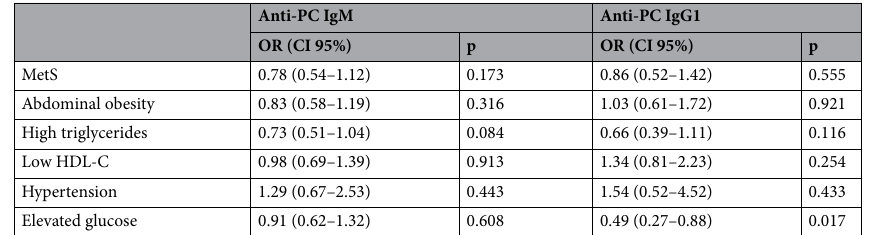
Table 4. Associations between anti-PC and MetS, including each component of MetS. Values are odds ratios (OR) with 95% confidence intervals (CI95%). MetS – metabolic syndrome. Components of the Metabolic syndrome (Abdominal obesity (waist circumference ≥ 88 cm and ≥ 102 cm for women and men, respectively), elevated triglycerides (≥ 1.7 mmol/L), reduced high density lipoprotein cholesterol (< 1.03 mmol/L in males and < 1.29 mmol/L in females), hypertension (systolic blood pressure ≥ 130 mmHg and/or diastolic blood pressure ≥ 85 mmHg, or drug treatment), or elevated fasting glucose (≥ 5.6 mmol/L or glucose-lowering treatment) were defined as stated by Alberti et al. 13 . Anti-PC antibodies against phosphorylcholine,